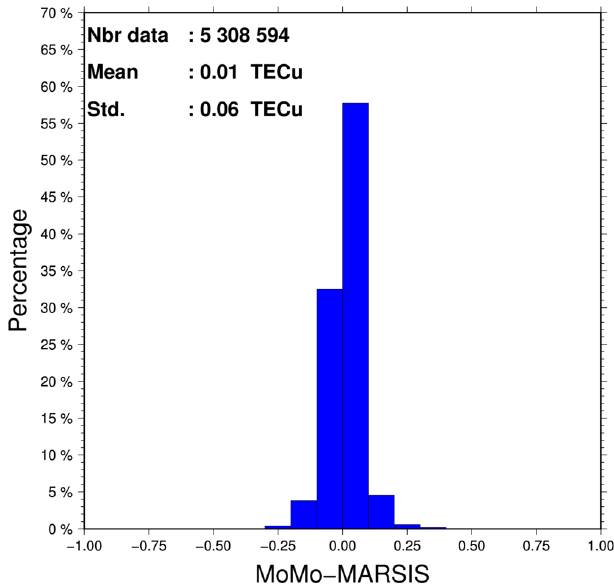
Fig. 4. Histograms of the differences between MoMo output and MARSIS data set used to constrain the equation (4) and the RMS of the model are available in Table 1. The model (subroutine sub_momo.f ) and the F 10 : 7 P index are available at https://lara.oma.be/marsatmo/iono/momo.html.